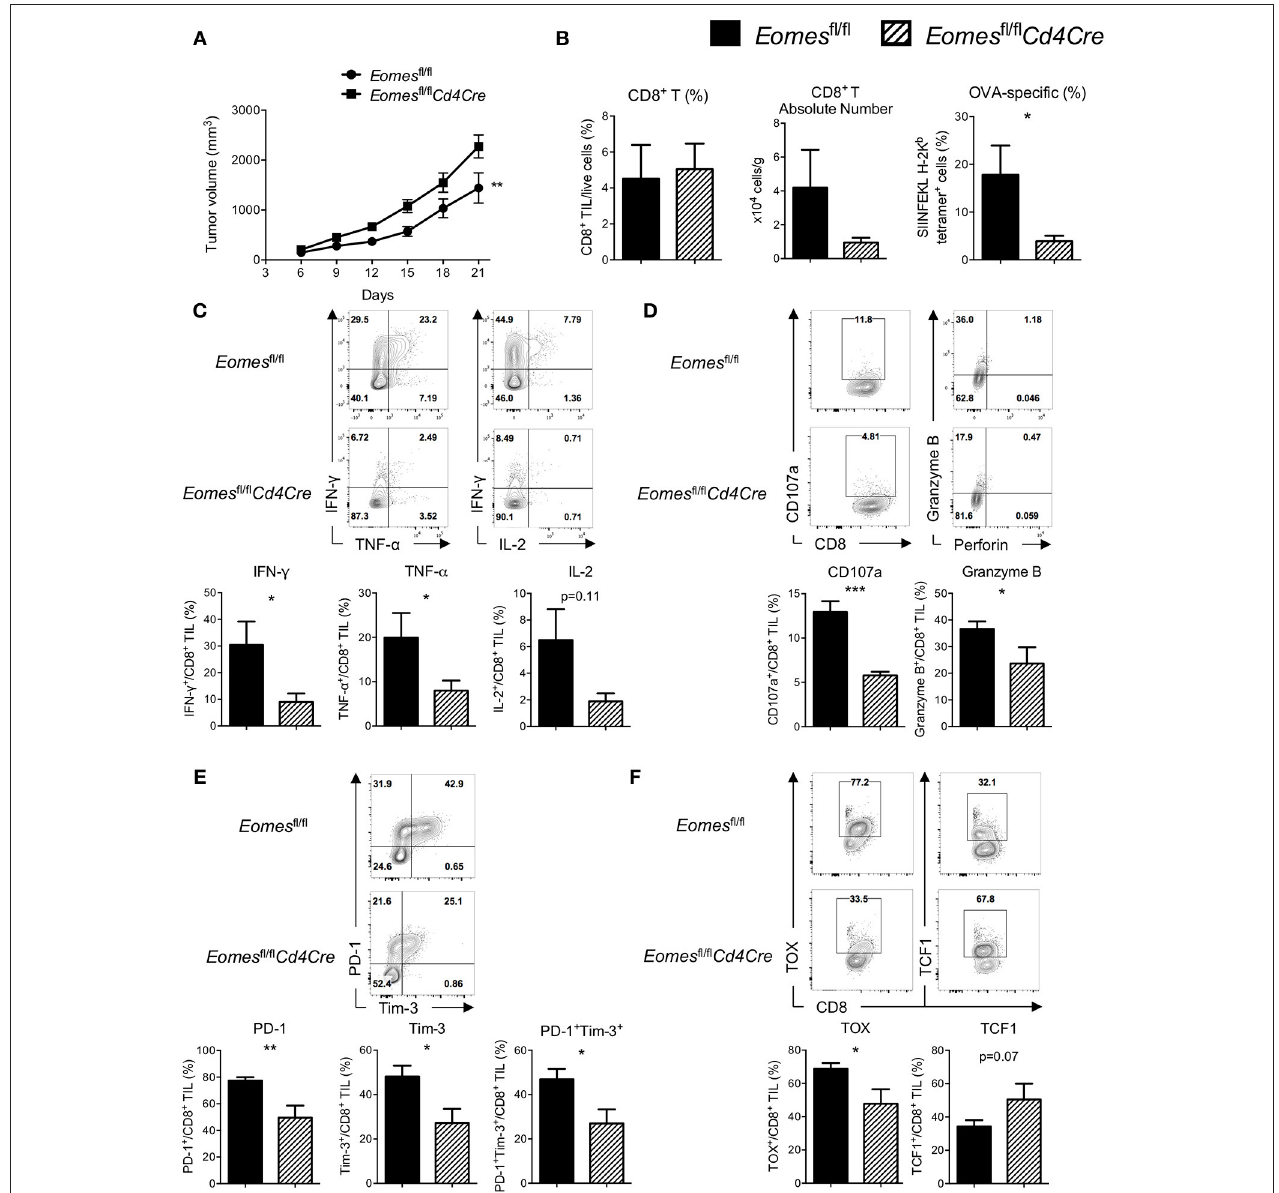
FIGURE 2 | Eomes is required for full development of anti-tumor CTLs. (A) Mean tumor volume of intradermal E.G7 implants in Eomes fl / fl vs. Eomes fl / fl Cd4Cre mice. (B) Summary histograms showing percentage of CD8 + TILs in total live cells, absolute number of CD8 + T cells in the tumor and frequency of OVA-specific CD8 + T (stained by SIINFEKL H-2K b tetramer) in total CD8 + TILs from Eomes fl / fl vs. Eomes fl / fl Cd4Cre mice on Day 21. (C) Production of IFN- γ , TNF- α and IL-2 by CD8 + TILs from Eomes fl / fl vs. Eomes fl / fl Cd4Cre mice on Day 21 after PMA/ionomycin stimulation. (D) Baseline surface expression of CD107a and PMA/ionomycin-stimulated expression of intracellular Granzyme B in CD8 + TILs from Eomes fl / fl vs. Eomes fl / fl Cd4Cre mice on Day 21. (E) Representative flow cytometric analysis and summary data of PD-1 and Tim-3 co-expression on CD8 + TILs from Eomes fl / fl vs. Eomes fl / fl Cd4Cre mice on Day 21. (F) Expression of TOX and TCF1 in CD8 + TILs from Eomes fl / fl vs. Eomes fl / fl Cd4Cre mice on Day 21 measured by intracellular flow cytometric analysis. Data are pooled from 2 independent experiments with 4–6 mice per group. Error bars denote mean ± SEM. Statistical analysis was performed using linear regression (A) or unpaired Student’s t -test (others). * p < 0.05, ** p < 0.01, *** p <